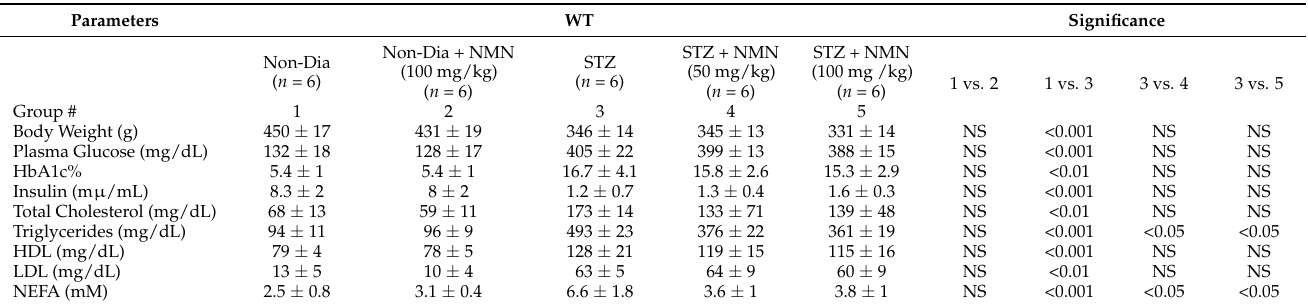
Table 1. Metabolic End Points After 2 Months of Treatment in Non-Diabetic (Non-Dia), NMN Treated Non-Diabetic (Non-Dia + NMN), Diabetic (STZ), NMN Treated Diabetic (STZ + NMN) Rats. NS = Not